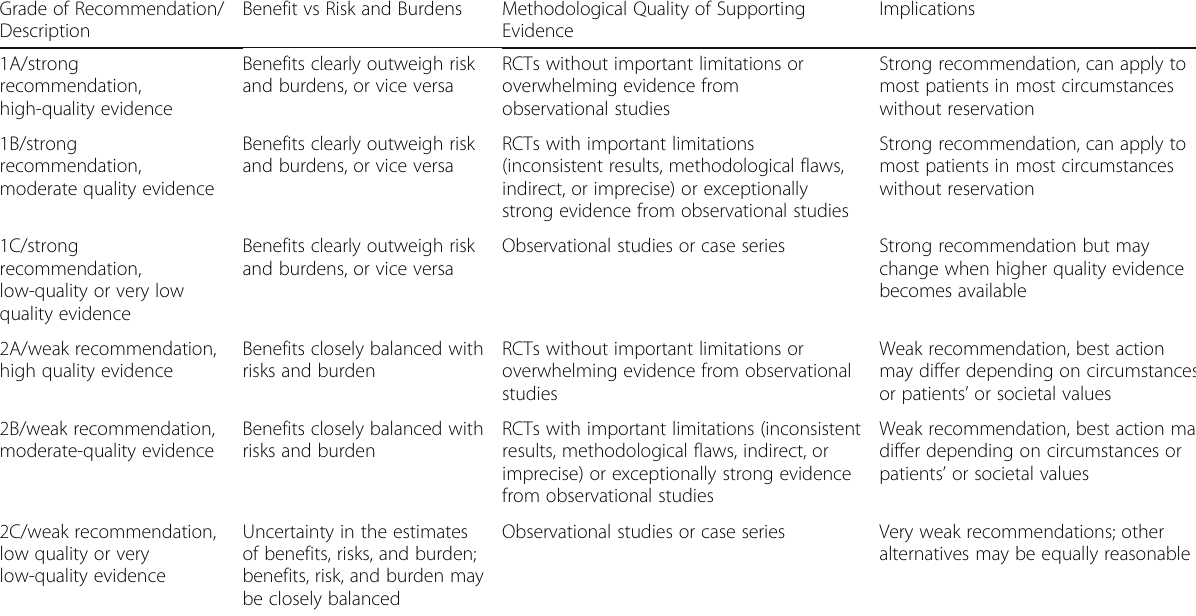
Table 1 Grading recommendations according to the American College of Chest Physicians (ACCP) Task